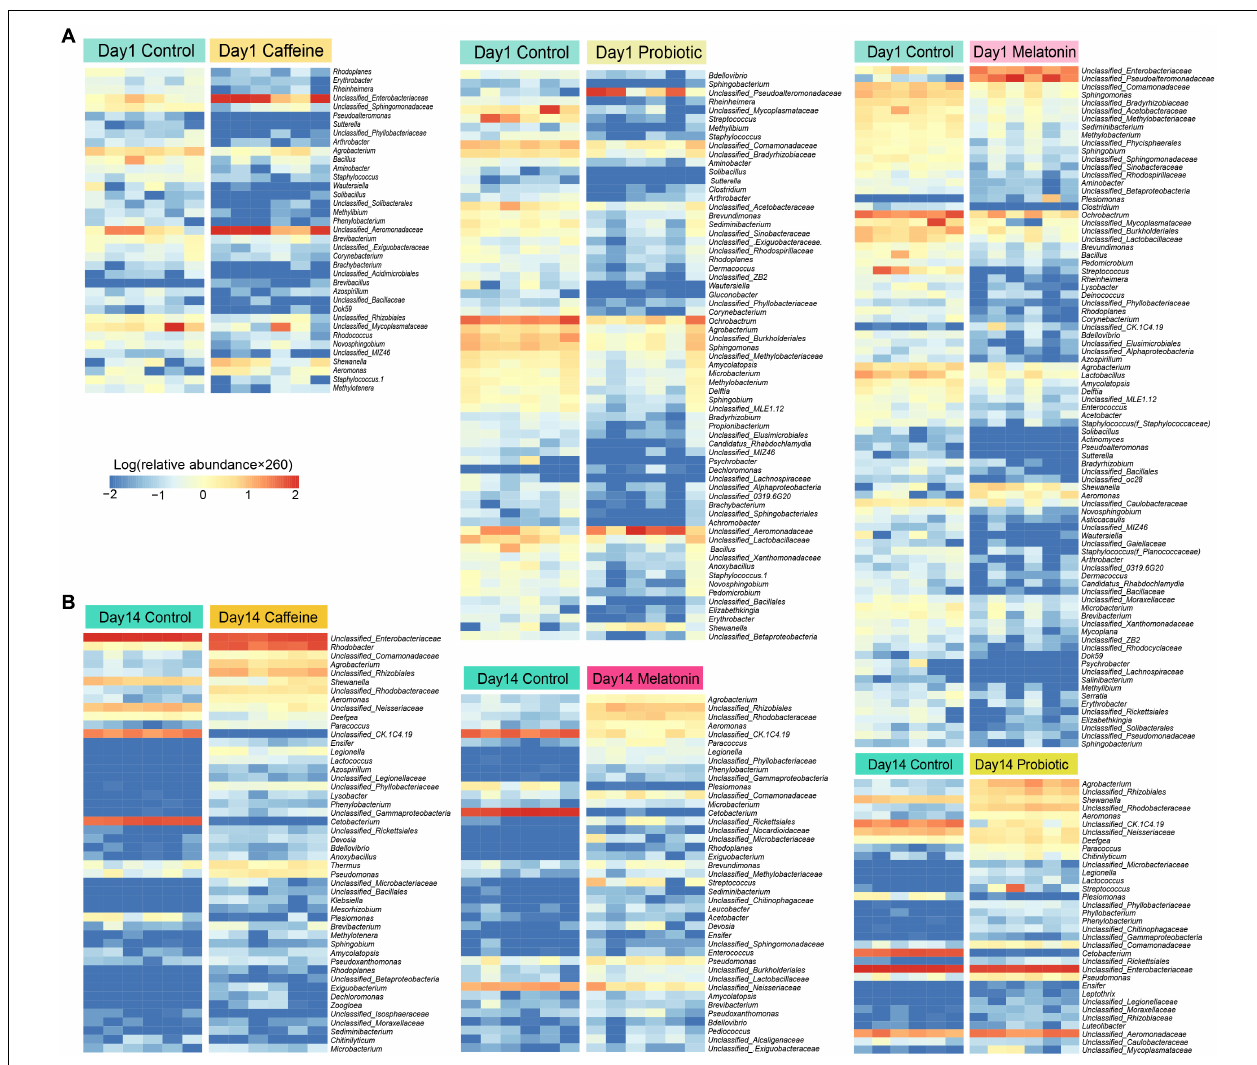
FIGURE 3 | Screening of differential genera in the caffeine group, melatonin group, and probiotic group compared with the control group on days 1 and 14. (A) The significant difference genera were screened in the caffeine group, melatonin group, and probiotic group compared with the control group on day 1. (B) The significant difference genera were screened in the caffeine group, melatonin group, and probiotic group compared with the control group on day 14. The depth degree of color represents the relative abundance of the genus or species (The blue indicates a small number and the red indicates a large number). Mann-Whitney test was used on days 1 and